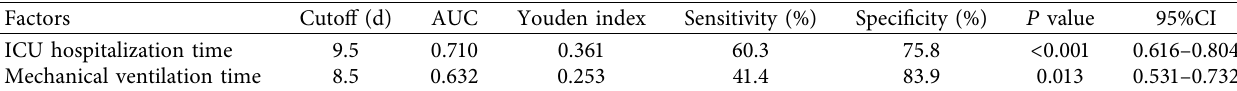
Table 5: ROC curve